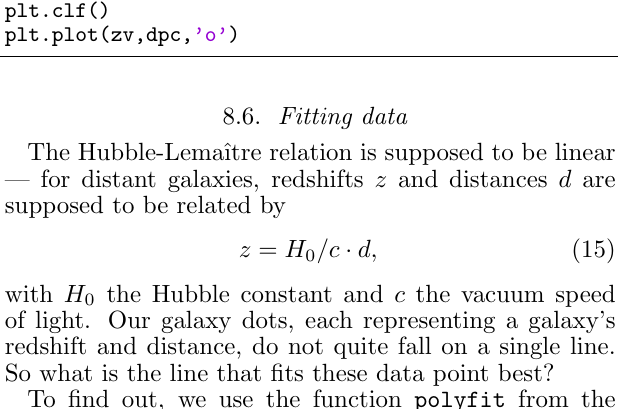
Last but not least, it is also possible to plot a scatter diagram using the plot function. Instead of the colour, you specify a data marker shape, in this case circles: plt.clf() plt.plot(zv,dpc,’o’)